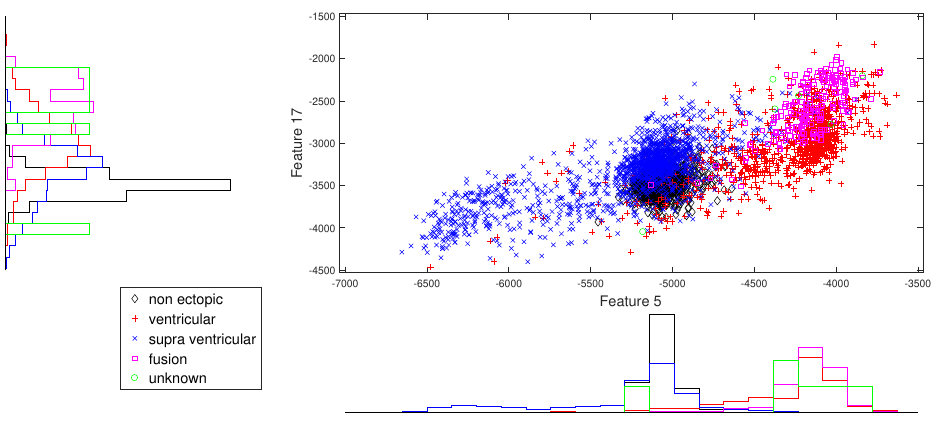
Figure 5. Scatter plot with marginal histogram for log entropy (IMF1) vs. log entropy (IMF3).